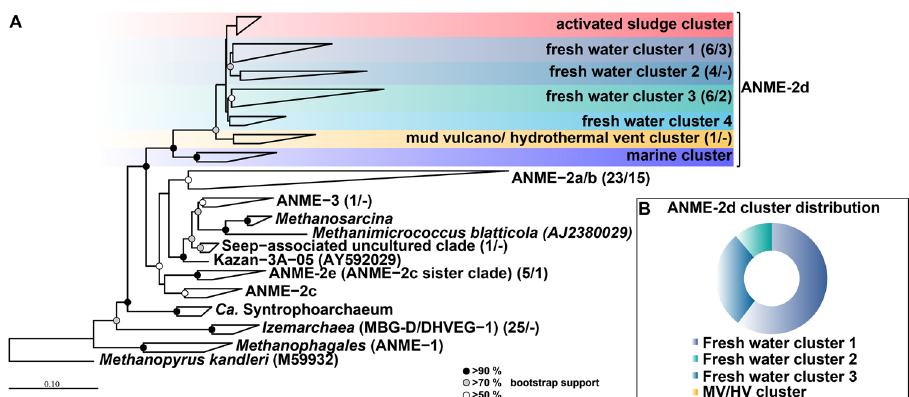
Figure 4. Phylogenetic affiliation of ANME sequences based on 16S rRNA gene. ( A ) The first number in the parenthesis represents the number of OTUs from the Illumina sequencing, while the second number represents the number of sequences of the clone library with ANME-specific primers. Methanopyrus kandleri was used as outgroup. The scale bar represents 10 percent sequence divergence. ( B ) The ring diagram represents the whole relative abundance of all ANME-2d sequences in both submarine permafrost